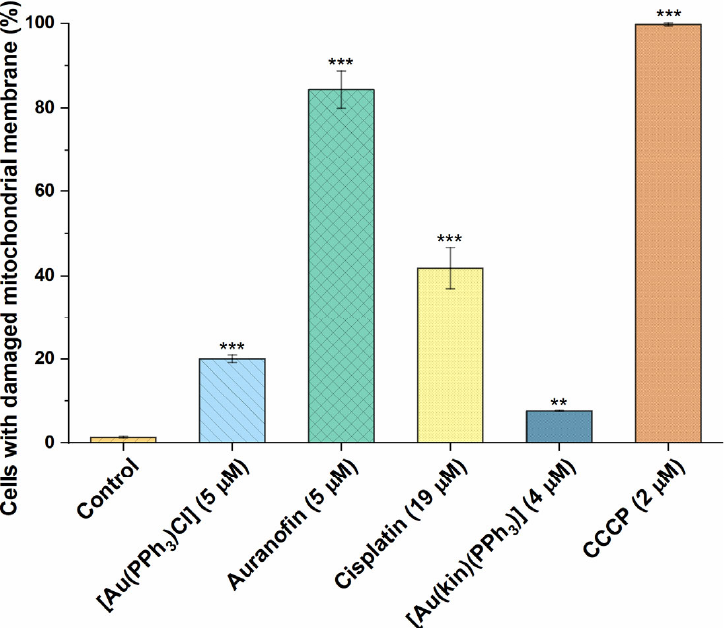
Figure 8. The demonstration of damage to mitochondrial membranes in A2780 cells after 24 h of incubation with half-cytotoxic concentrations caused by ( 1 ), the starting complex [Au(PPh 3 )Cl], and the reference drugs Auranofin and Cisplatin . The statistical significance was considered at the following levels: ** p < 0.01, *** p < 0.001 with respect to the untreated control group. The positive control represents the cells treated with carbonyl cyanide chlorophenylhydrazone (CCCP), a well- documented agent causing the mitochondrial function disruption.